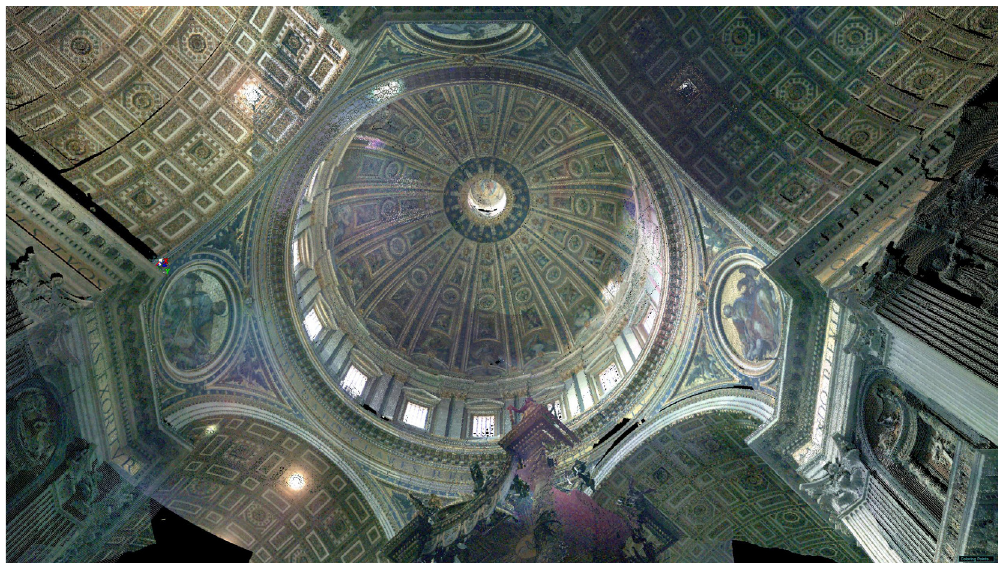
Fig. 10 Bianchini C., S. Peter’s Dome, 3D texturized point cloud from